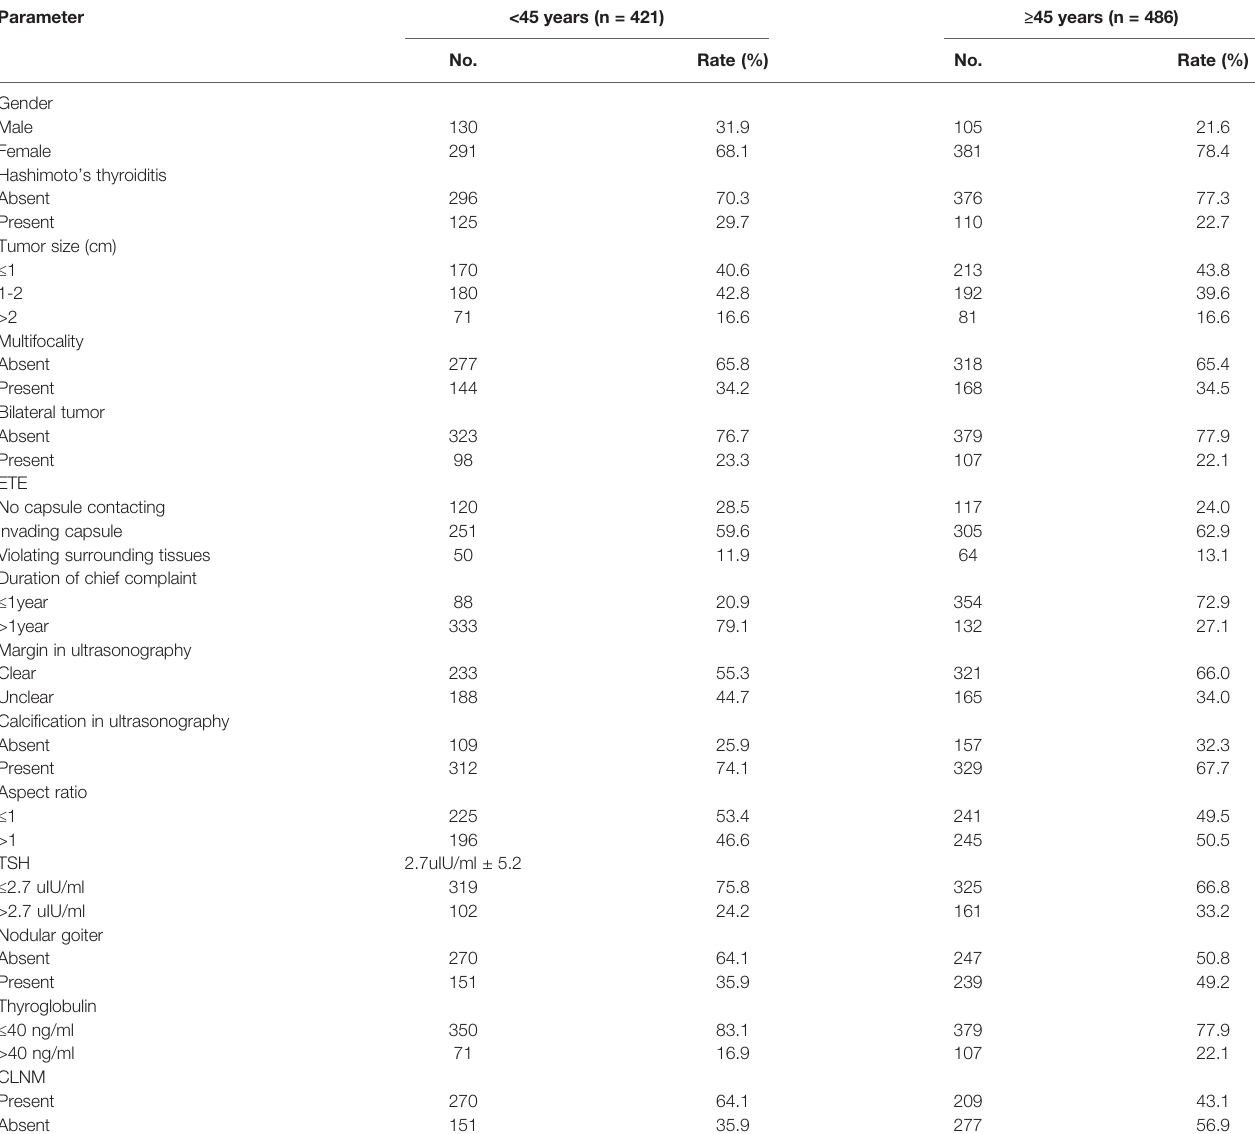
TABLE 1 | Clinicopathological characteristics of the 907 PTC